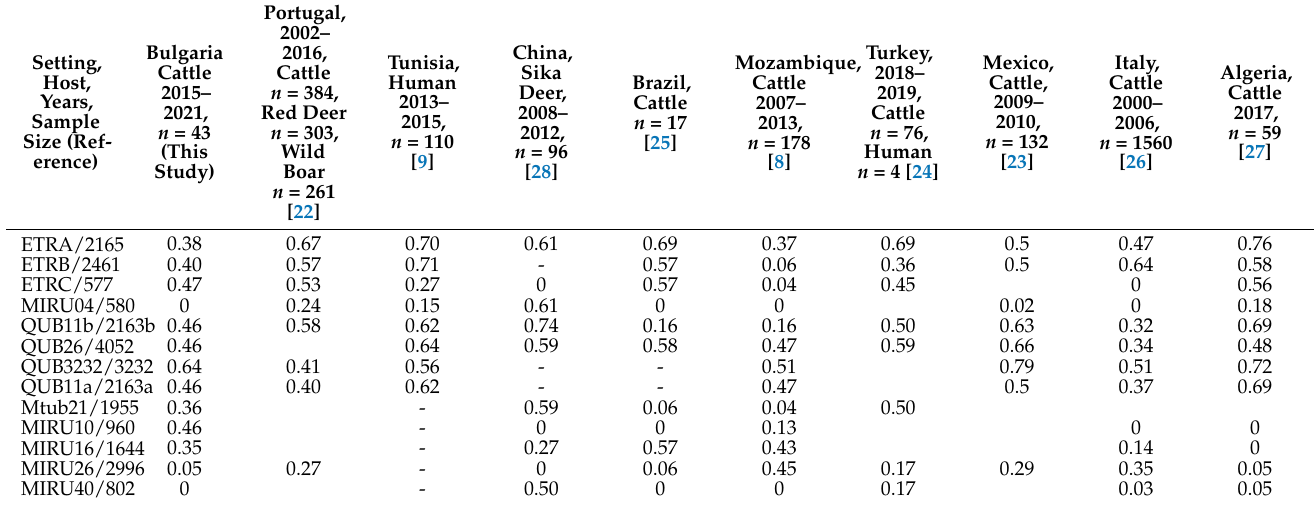
Table 4. Diversity of 13 VNTR loci in M. bovis in this and other